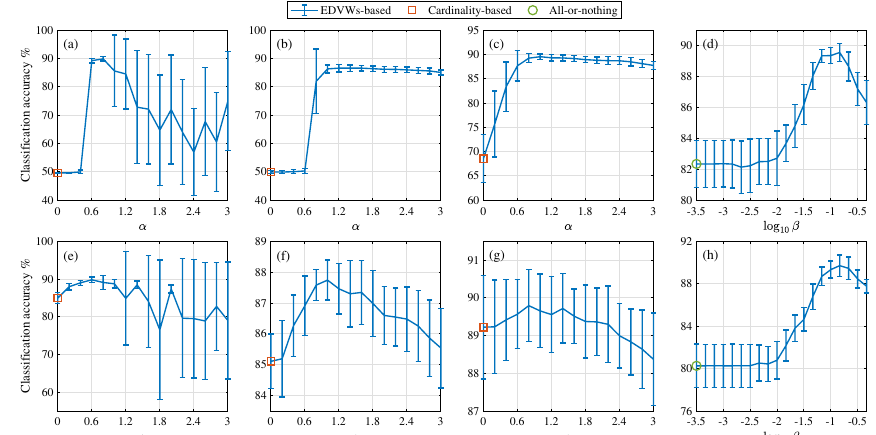
Fig. 3 Classification performance as a function of the parameters α and β . For the two rows, the fraction of labeled vertices is respectively set to 0.3 and 0.5. ( a ) and ( e ) correspond to the splitting function w e ( S ) = γ e ( S ) · γ e ( e \ S ) ; ( b ) and ( f ) correspond to the splitting function w e ( S ) = min { γ e ( S ) , γ e ( e \ S ) } ; ( c ), ( d ) and ( g ), ( h ) correspond to the splitting function w e ( S ) = min { γ e ( S ) , γ e ( e \ S ) , βγ e ( e ) } where we fix β = 0.15 in ( c ), ( g ) and we fix α = 1 in ( d ), ( h